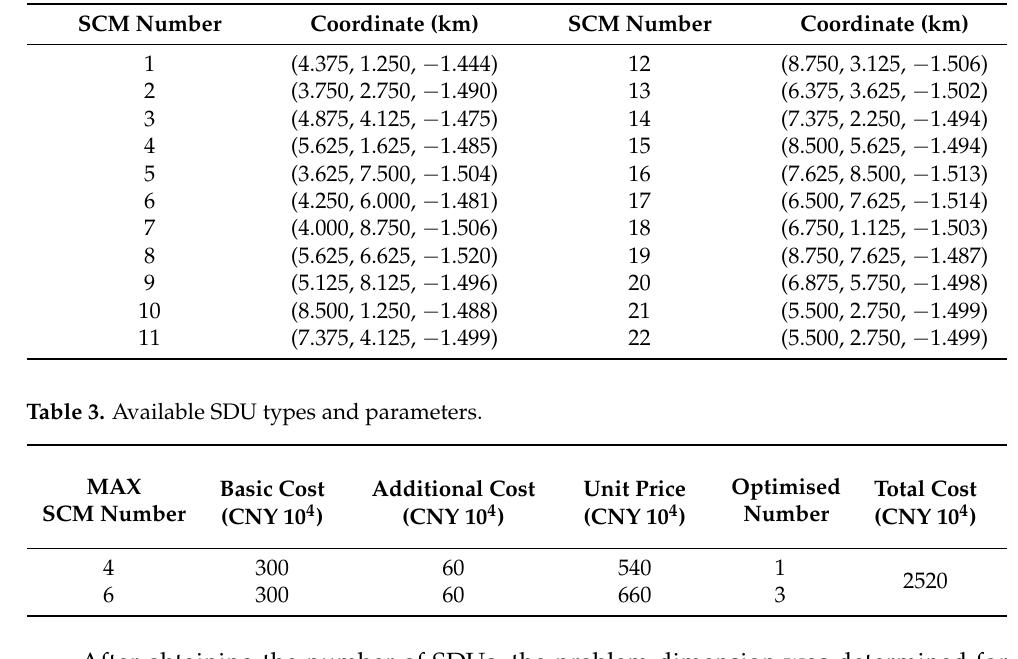
Figure 5. Seabed terrain and SCM distribution. Table 2. Coordinate data of SCMs.